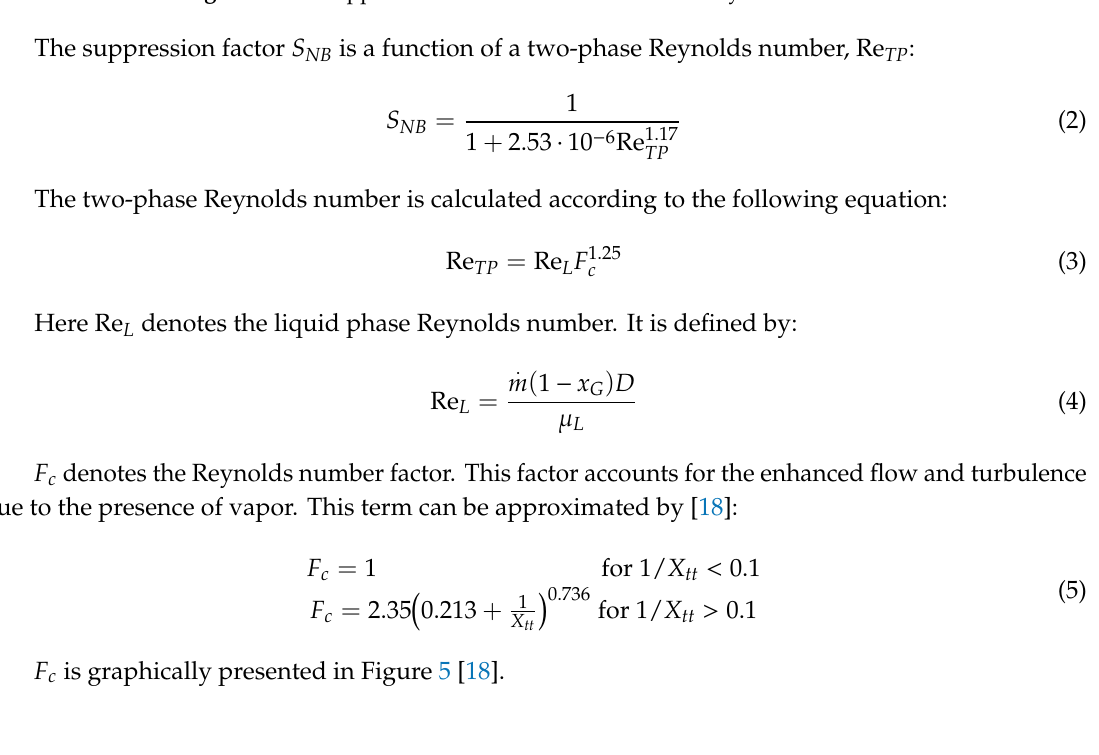
Figure 4. The suppression factor as function of total Reynolds number.